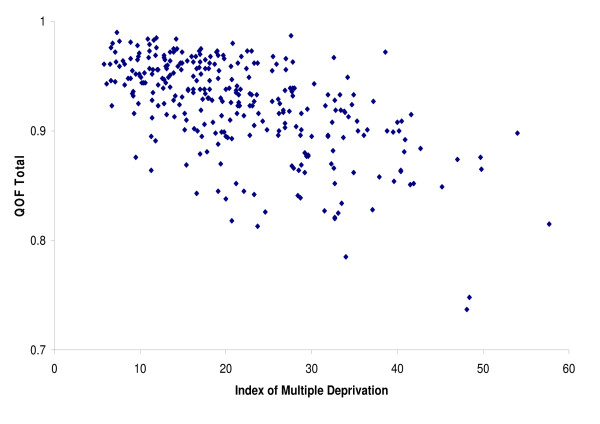
Correlation between IMD score and QOF total.